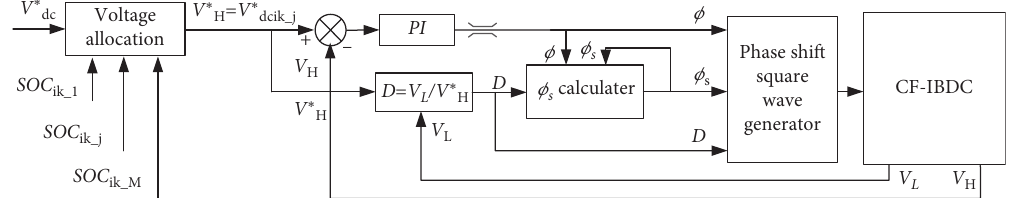
Figure 6: SOC layer control strategy block